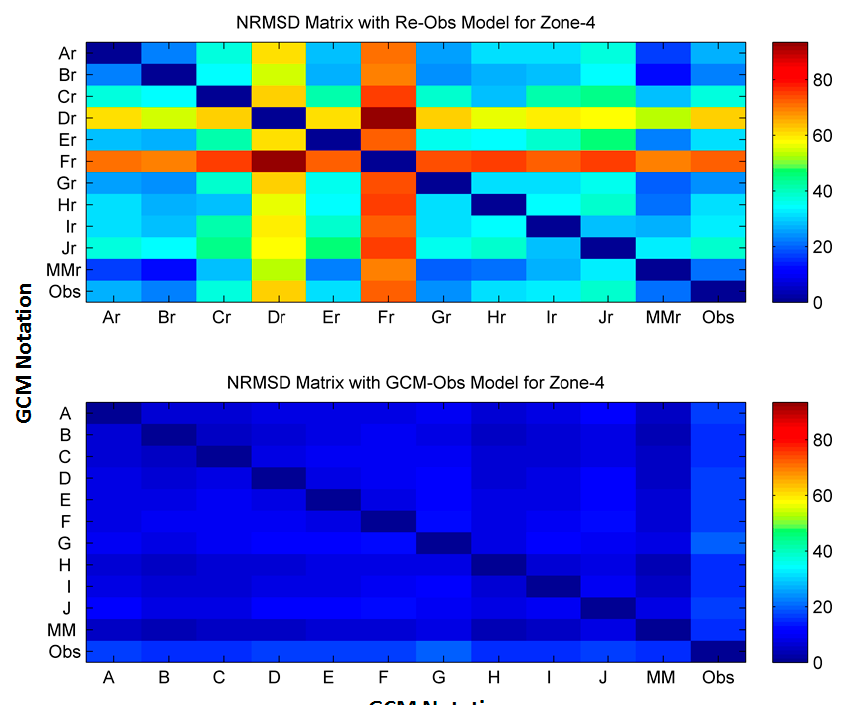
Figure 21. NRMSD matrix for downscaled precipitation for different GCMs with Re-Obs and the GCM-Obs model for zone 4. The coloured bar represents the NRMSD percentage. GCM notations are the same as the ones marked in Figure 17.